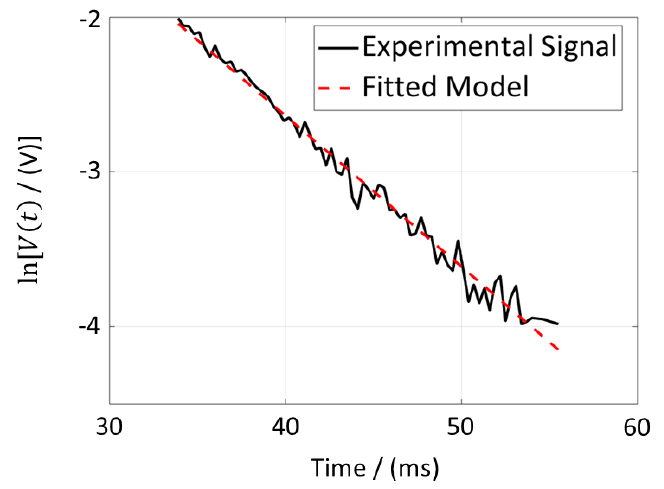
Figure 8. Least-squares line-fitting example, grey cast iron with 20 mm thickness at 12 mm lift-off (RMSE =